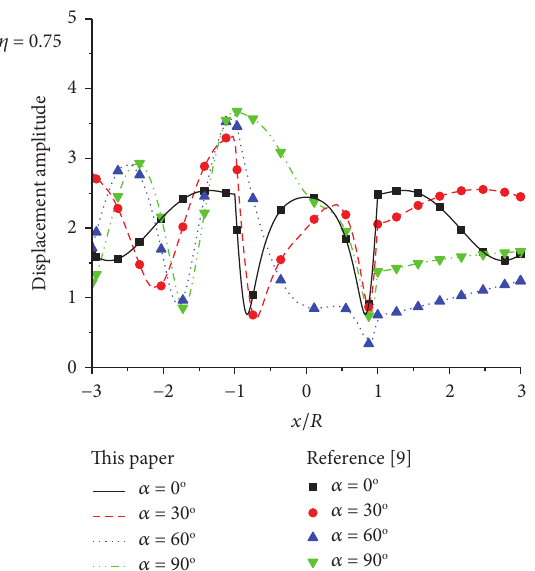
Figure 3: Surface displacement amplitude of degraded semicircular depression.